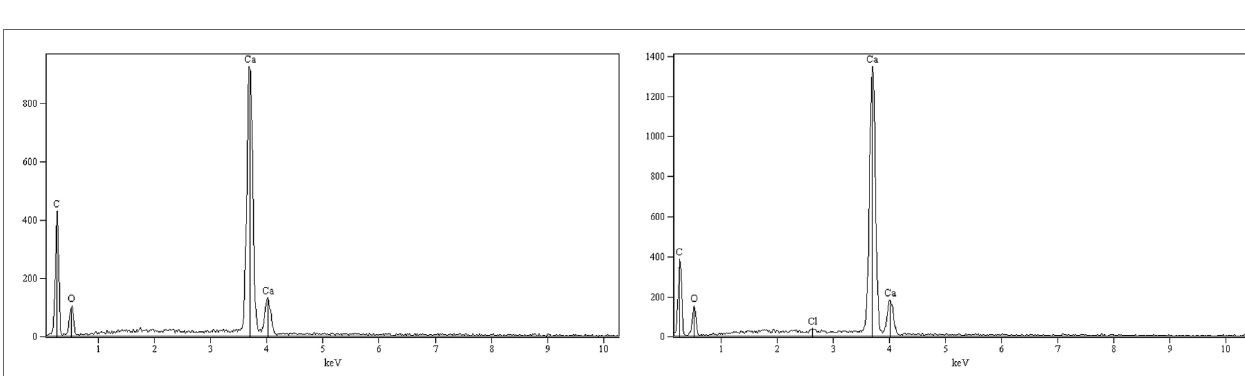
FigUre 12 | eDs spectra of solids separated by pressure filtration from the calcite slurry (left) and from the aragonite slurry (right) .